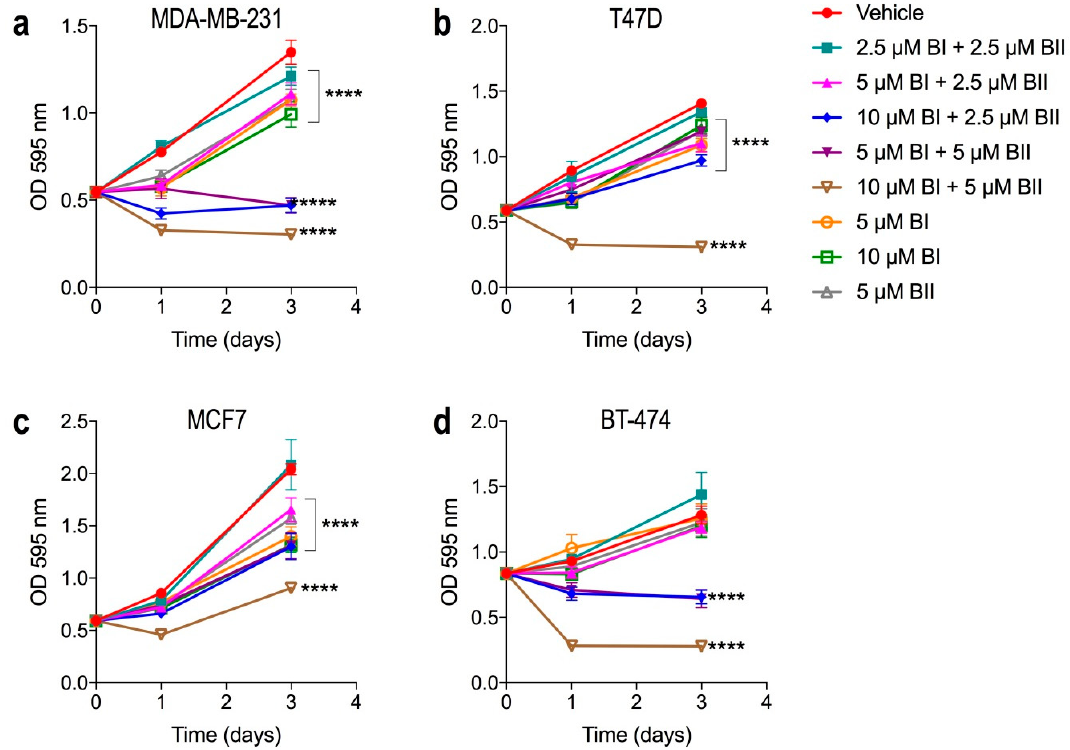
Figure 2. Bac I and II combined reduced breast cancer cell proliferation. BI: bac I; BII: bac II. Cells were seeded in 96-well plates and treated with bac I (BI) and bac II (BII), alone or in combination: a , MDA-MB-231; b , T47D; c , MCF7; d , BT-474. Plates were stained with crystal violet on days 0, 1, and 3 of treatment. Data are the mean ± SD of six replicates from a reproducible experiment. p -values shown are for absorbance on day 3, comparing treatment relative to the vehicle, as determined by two-way ANOVA with multiple comparisons and Bonferroni test (**** p < 0.0001).